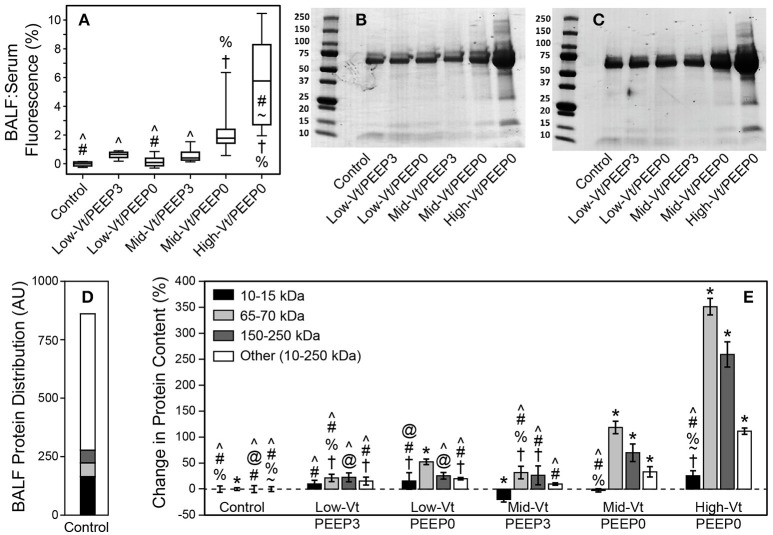
(A) Ratio of bronchoalveolar lavage fluid (BALF):Serum fluorescense demonstrates significantly increased leak (with respect to the control group) of retro-orbitally injected 4 kDa dextran molecules into airspace. The fluorescence ratio was linearly related to BALF protein (y = 0.112 + 0.269x, R2 = 0.92, p < 0.005). Panels (B,C) show representitave Coomassie G-250 blue staining used for quantitative densitometry. (D) Distribution of small (10–15 kDa, black), medium (65–70 kDa, light gray), large (150–200 kDa, dark gray), and all other protein species in the 10–250 kDa range (white) in the BALF as determined by densitometric analysis for the control group. (E) Percent changes in the protein content for each ventilation group compared to control showing significant increases in medium and large proteins caused by Mid-Vt/PEEP0 and High-Vt/PEEP0 ventilation. Significant difference from all other groups (*), from control (†), Low-Vt/PEEP3 (~), Low-Vt/PEEP0 (%), Mid-Vt/PEEP3 (#), Mid-Vt/PEEP0 (@), and High-Vt/PEEP0 (∧). Error bars show the standard deviation.